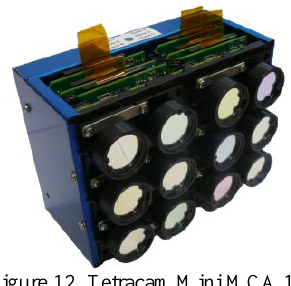
Figure 12. Tetracam Mini MCA 12